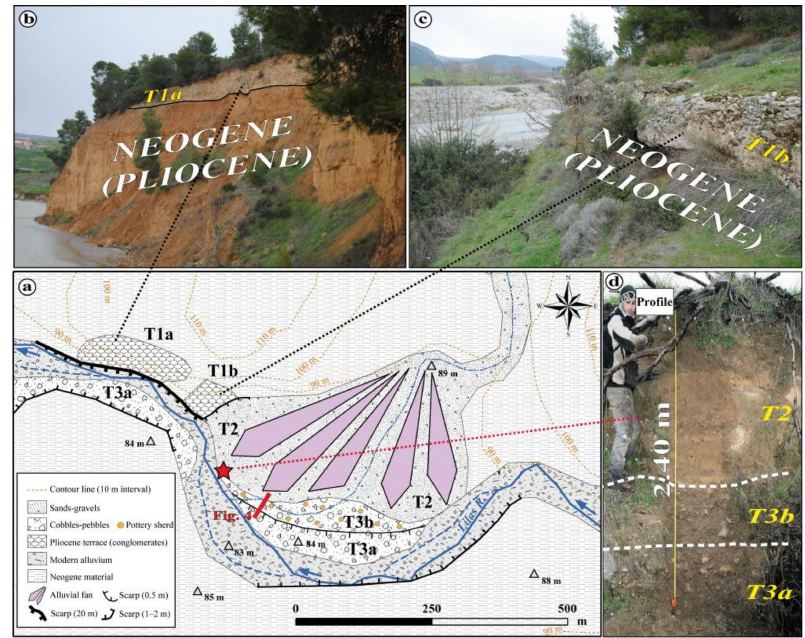
Figure 3. ( a ) Morphostructural mapping and terraces geometry. Topographic information is derived from 1:5000 scale maps. The red line indicates the position of the cross section revealing the terraces T3a, T3b and T2 (Figure 4); the red star indicates the position of the studied profile ( d ); Pliocene terraces are reported on ( b , c